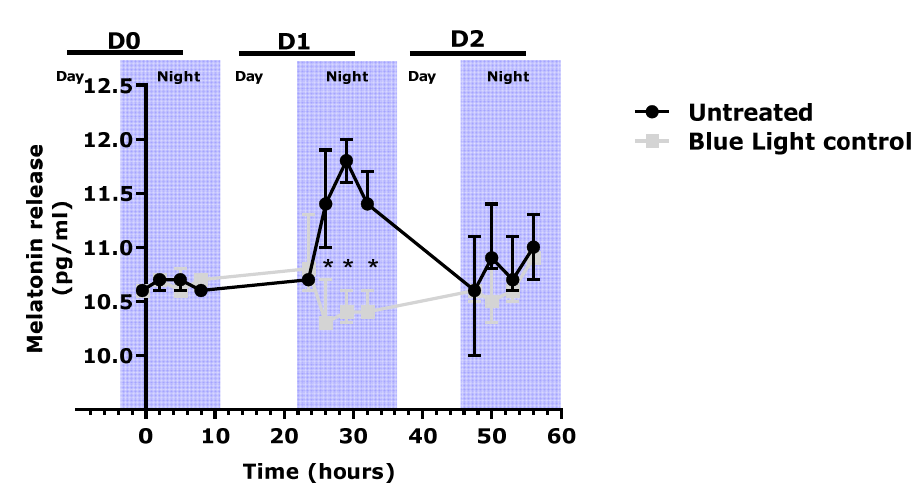
Figure 5. Quantification of melatonin release in the co-culture medium of cells exposed or not exposed to blue light stress (20 mJ/cm²). Statistical analysis with a Kruskal–Wallis ANOVA, followed by a Mann–Whitney U test in comparison to the blue light control, where * p < 0.05. Legend: D0 = Day 0; D1 = Day 1; D2 = day 2.